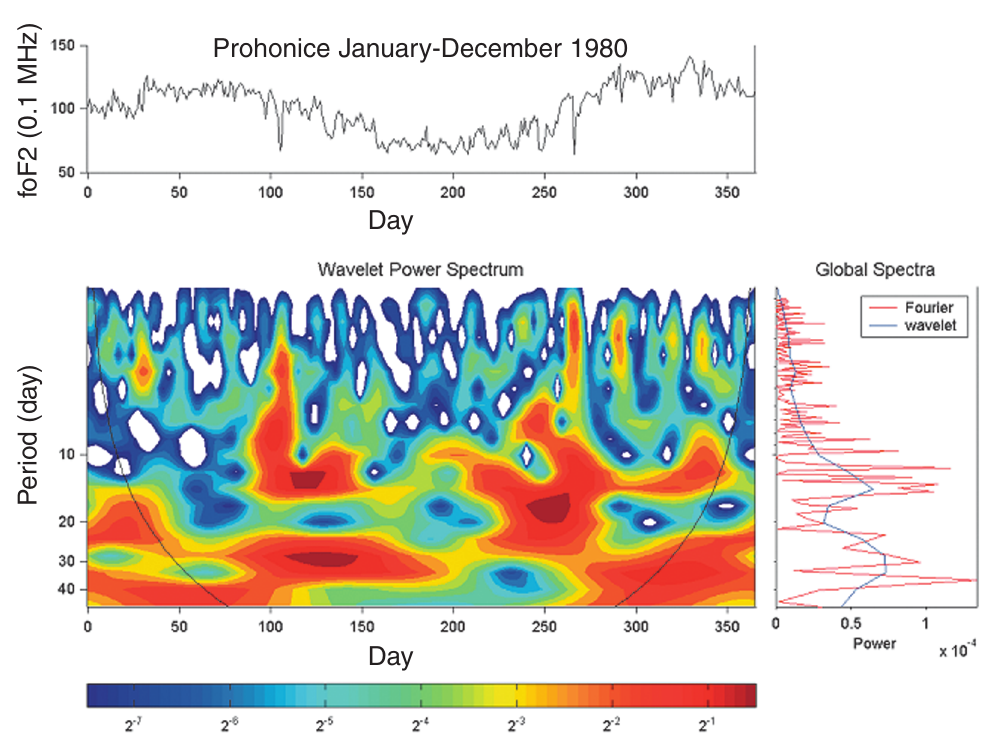
Fig. 4. Planetary wave activity inferred from foF 2 for Pru˚honice, January-December 1980, Top panel: time se- ries of raw foF 2 data. Bottom left panel: wavelet transform power spectrum of the planetary wave activity. Pow- er spectrum is normalized to 1. Bottom right panel: global (over 365 days) Wavelet and Fourier